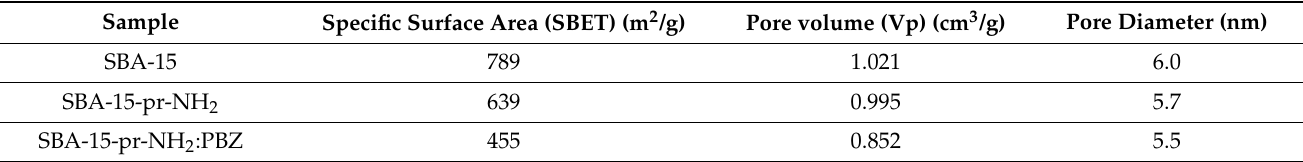
Figure 3. Nitrogen adsorption-desorption isotherms of SBA-15-pr-NH 2 and SBA-15-pr-NH 2 :PBZ. Table 1. Textural parameters of SBA-15, SBA-15-pr-NH 2 , and SBA-15-pr-NH 2 :PBZ.